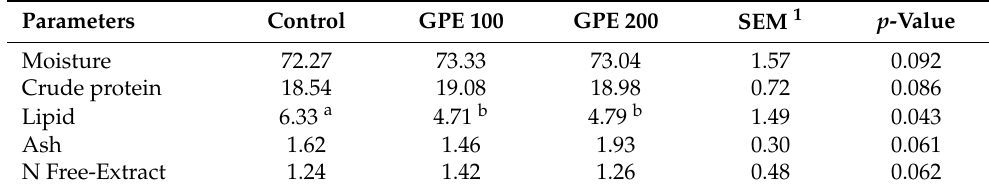
Table 4. Chemical composition of fillets from European sea bass fed diets with two levels of red grape